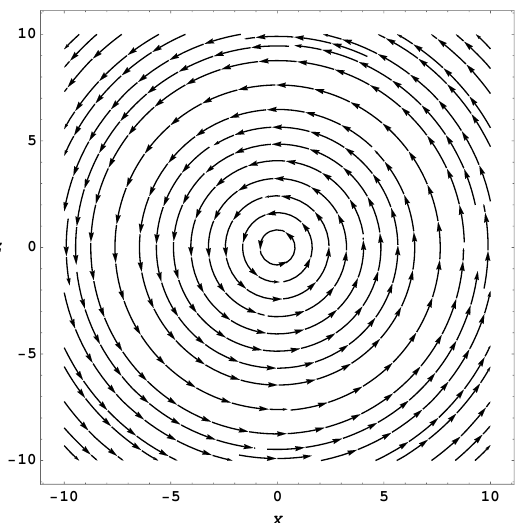
Figure 4. The velocity field in the planes x = 0 ( a ) and x = ± 5 ( b ) as per Equation (54).